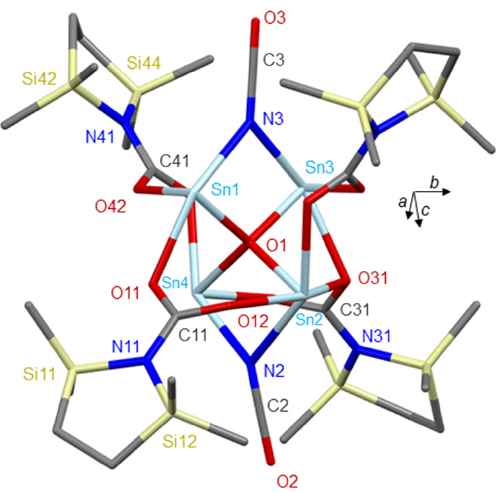
Figure 3. Molecular structure of 4 , adapted from [50] (MERCURY view). Hydrogen atoms are omitted for clarity (Sn light blue, O red, N dark blue, C grey, Si light yellow).